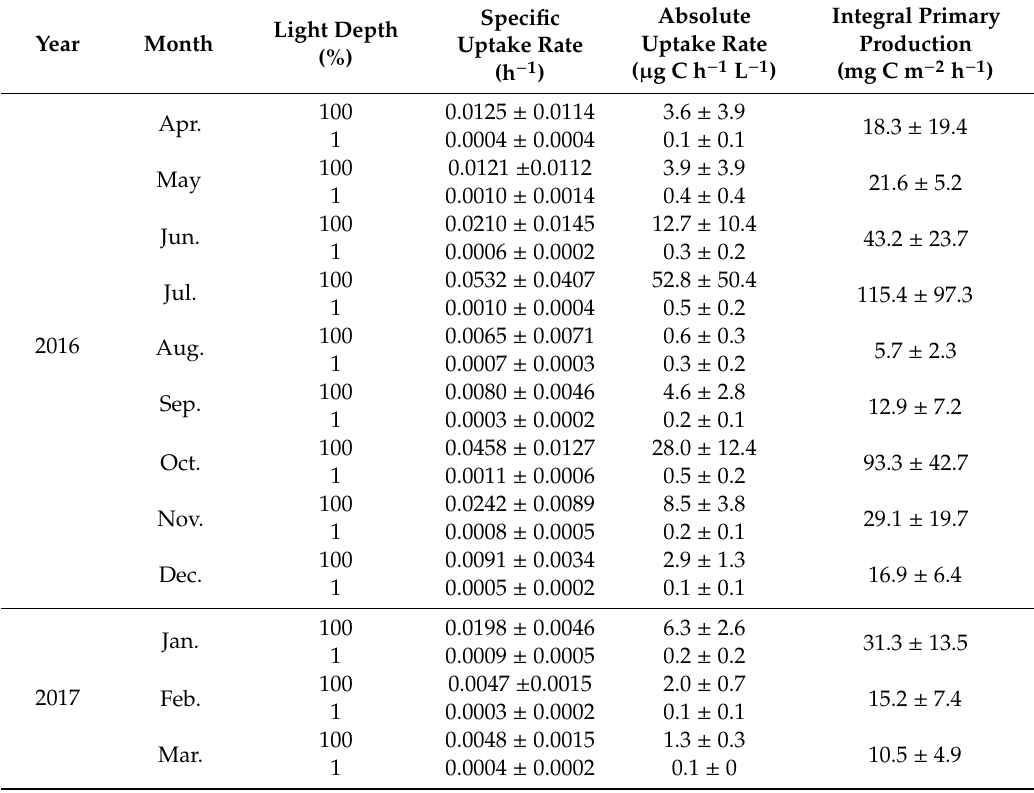
Table 2. Station-averaged specific and absolute carbon uptake rates and primary production of phytoplankton at the 100% and 1% light depths in Jaran